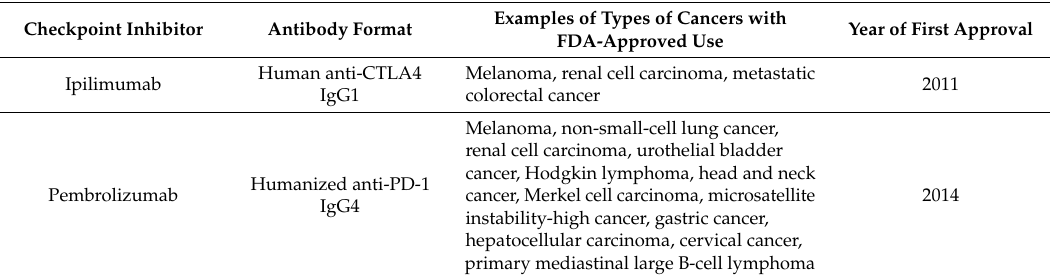
Table 2. The list of Food and Drug Administration (FDA)-approved monoclonal antibodies acting as inhibitors of negative checkpoints in human cancer